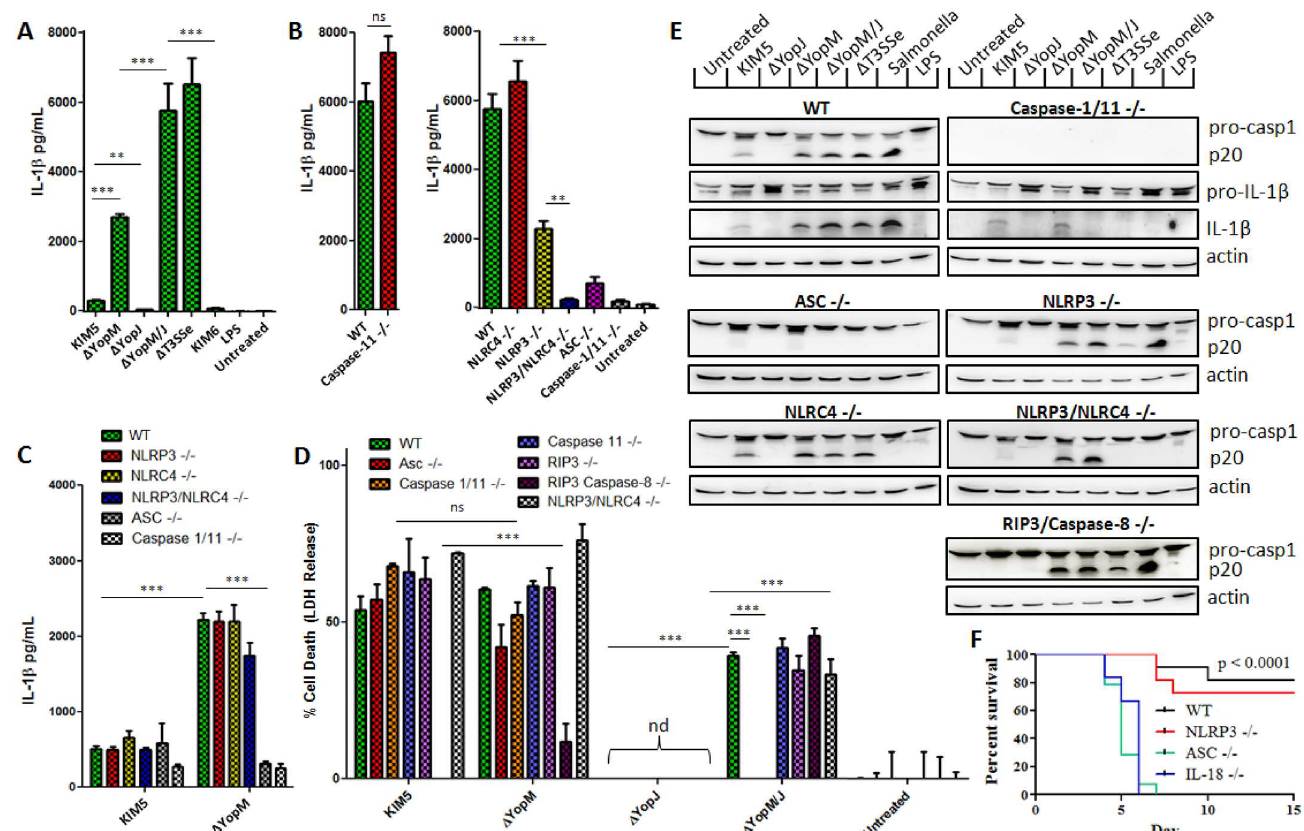
Fig 1. The Y . pestis effector YopM suppresses a different IL-1 β -producing pathway than the one triggered by the needle/translocon through NLRP3 and NLRC4. IL-1 β in supernatants from A) WT LPS-primed BMDMs infected with Y . pestis Yop mutant strains, B) BMDMs of indicated genotypes infected with Δ T3SSe, or C) LPS-primed BMDMs infected with KIM5 and Δ YopM were measuredby ELISA 6 hrs p.i. (MOI 10). D) Cell death was assayed by LDH release in LPS-primed BMDMs infected with indicatedstrains at 6 hrs p.i. (MOI 10). Figures are representative of three or more experiments. E) Total protein from LPS-primed BMDMs infected with indicatedstrains (combined cell lysate and supernatant) was separatedby SDS-PAGE and analyzedby Western Blot for IL-1 β and caspase-1. F) Mice of indicatedgenotypes were injected s.c. with 160 CFU of KIM1001 Δ M/J and monitored for survival past 21 days. P value for survival comparisons reflect differences betweenWT (n = 11) or NLRP3 KO (n = 11) and IL-18 (n = 6), Asc KO (n = 14). Shownis mean plus s.d. for triplicate wells. ND: not detected. A-E are representative of three experiments or more, F representative of two experiments performed. * p < 0.05, ** p < 0.01, *** p < 0.001.